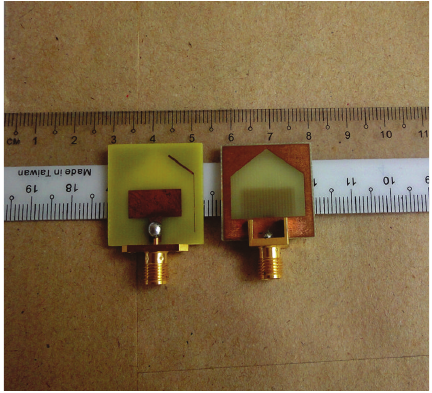
Figure 5: Photograph of the proposed